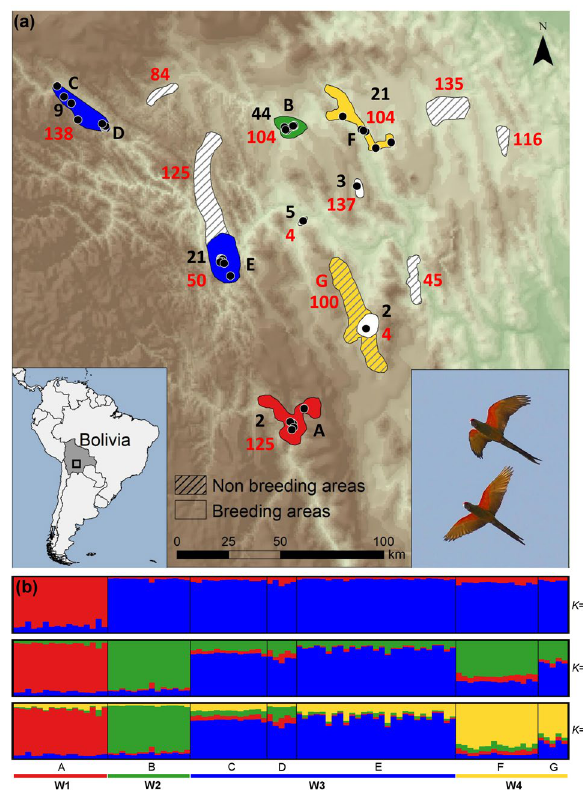
Figure 1. ( a ) Distribution range of the red-fronted macaw showing the sampled population nuclei (represented by letter codes: black letters for breeding nuclei, red letter for the single non-breeding area sampled) pooled in genetic clusters (represented by colours). The number of breeding pairs in each population nucleus at the time this study was conducted is represented by black numbers, while the maximum flock size in each breeding and non-breeding areas is represented by red numbers. Black points represent breeding colonies. ( b ) Distinct genetic clusters from the Bayesian clustering analysis with prior information on sampling location are shown for several K clusters. Each vertical line corresponds to one individual and the different colours represent the assignment to each cluster, with K = 4 as the optimal number of clusters estimated. Map was generated with ArcGIS 10.5